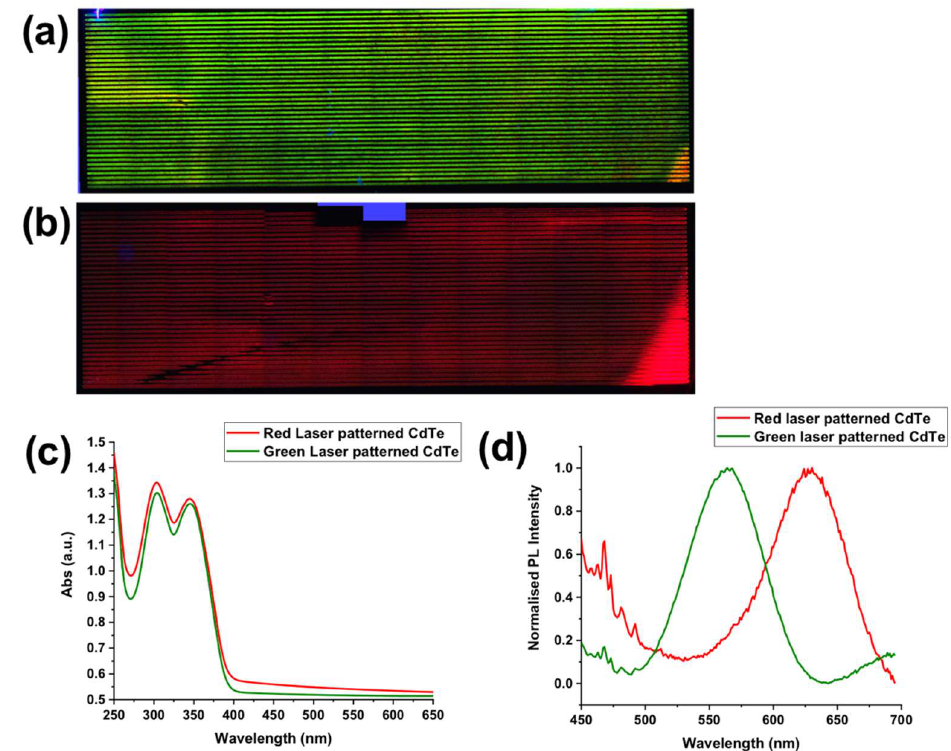
Figure 8. Large area image of the green ( a ) and red ( b ) sample (PMMA 200 mg/mL and Cd(ISA) 2 40 mg/mL) acquired with fluorescent microscope. ( c ) absorption spectra of the green and red large area samples; ( d ) PL spectra of the green and red large area samples at exc of 350 nm. The green emission is centered at 554 ± 12 nm (average ± 2 × average standard error for a confidence interval of 95%) with an FWHM of 58 ± 10 nm (average ± 2 × average standard error for a confidence interval of 95%). On the other hand, the red emission is centered at 629 ± 12 nm (average ± 2 × average standard error for a confidence interval of Table 6. Position and FWHM values of the PL peaks as a function of the calculated dose values 95%) with an FWHM of 64 ± 2 nm (average ± 2 × average standard error for a confidence and the laser-writing parameters. interval of